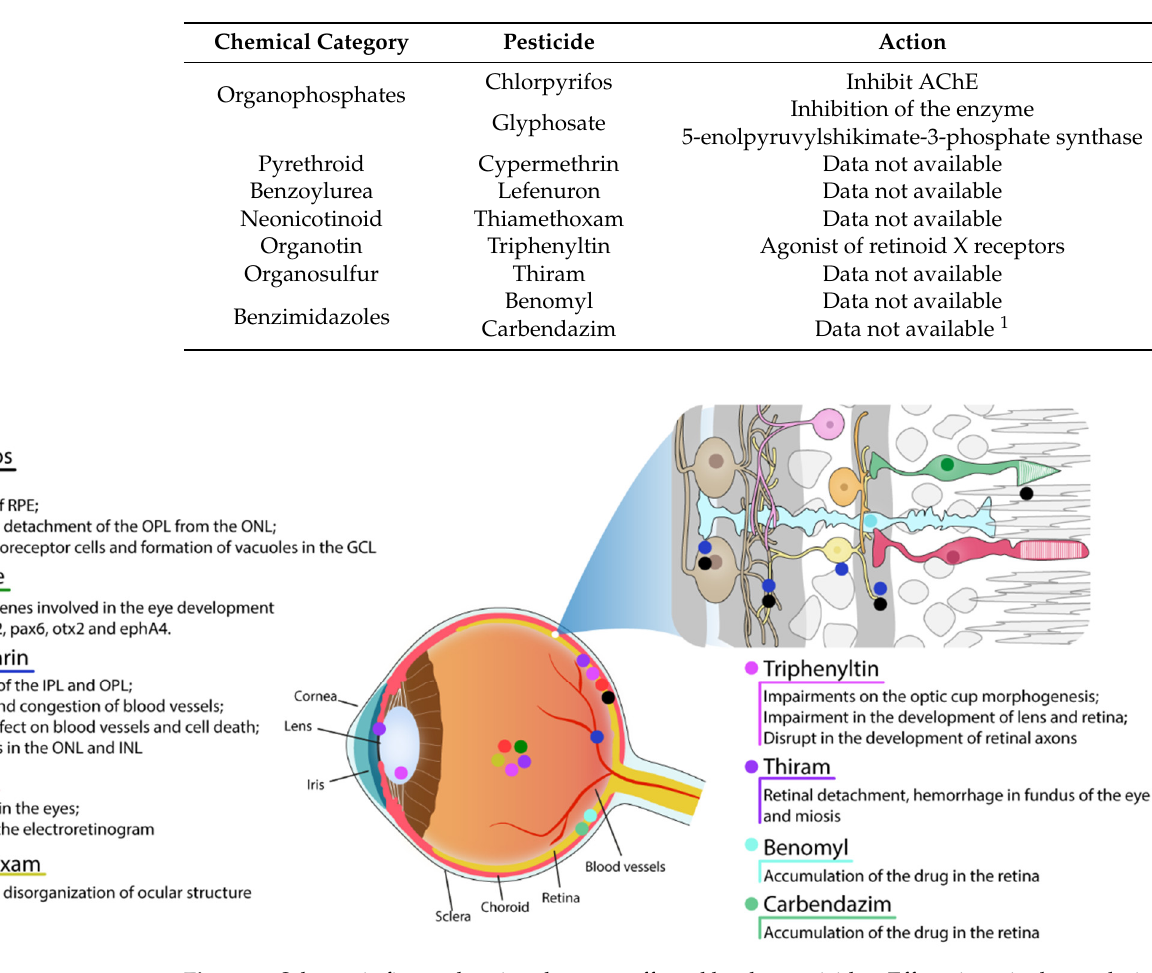
Figure 1. Schematic figure showing the areas affected by the pesticides. Effects in retinal vascularization and RPE are showed in the eye draw whereas in neural retina are represented in retinal